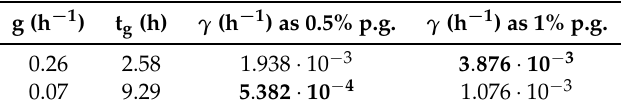
Table A7. The death rate ( γ ) coefficients evaluated from different growth rates (g) using the generation time (t g ) and percentage death rate per generation (%